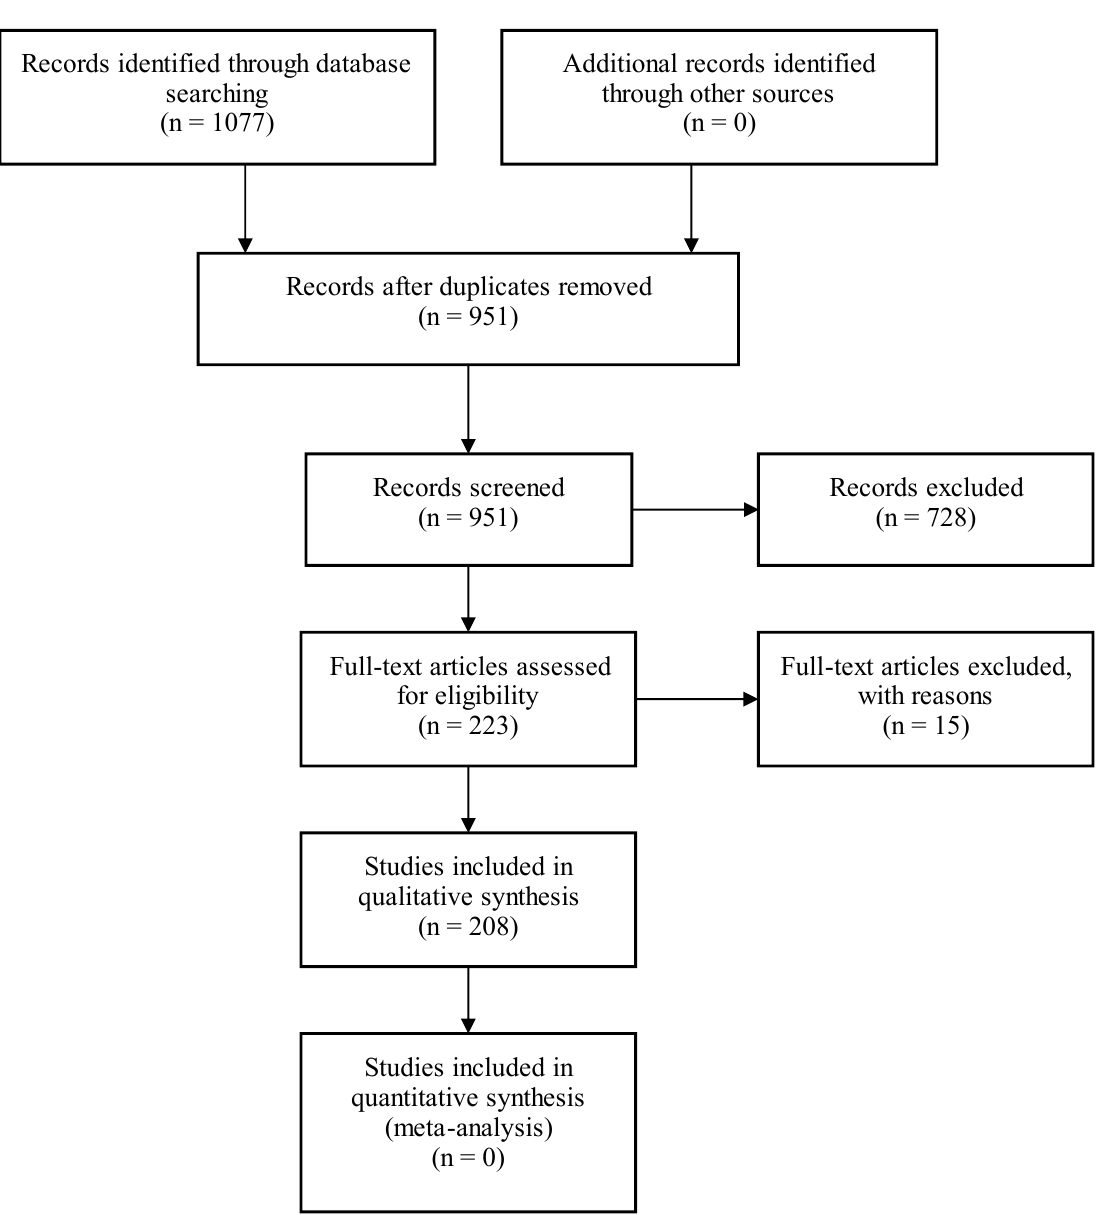
Figure 1. PRISMA flow diagram for the current study.